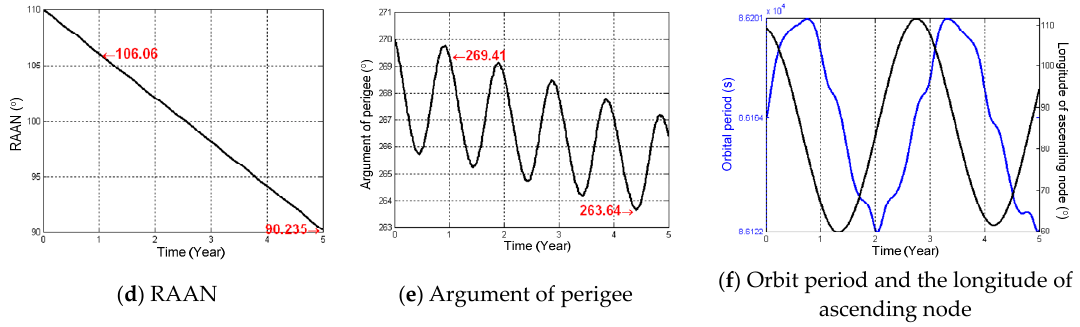
Figure 3. Curves of perturbed GEO SAR orbital elements variations within five years.